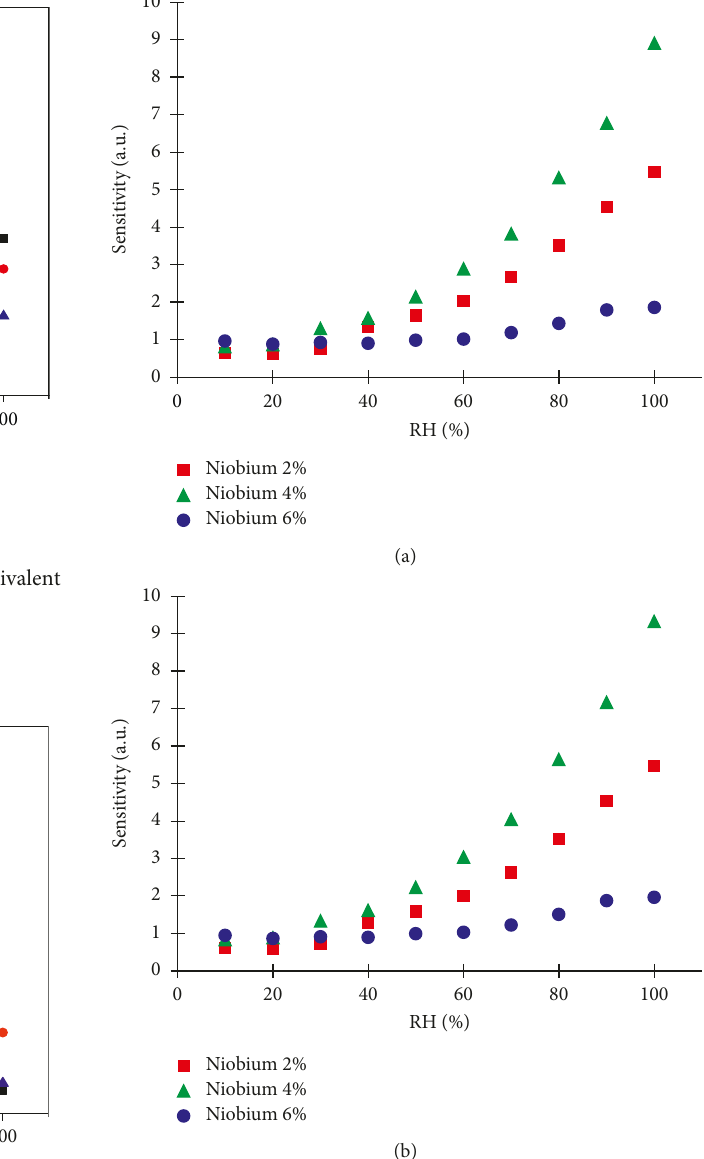
Figure 10: Sensitivity change with RH, at 1.3kHz (a) and 4kHz (b), at 20 ° C for all three sensors. Figure 9: Dependence of R 2 —fitting parameter of equivalent circuit with RH variation at different doping levels.